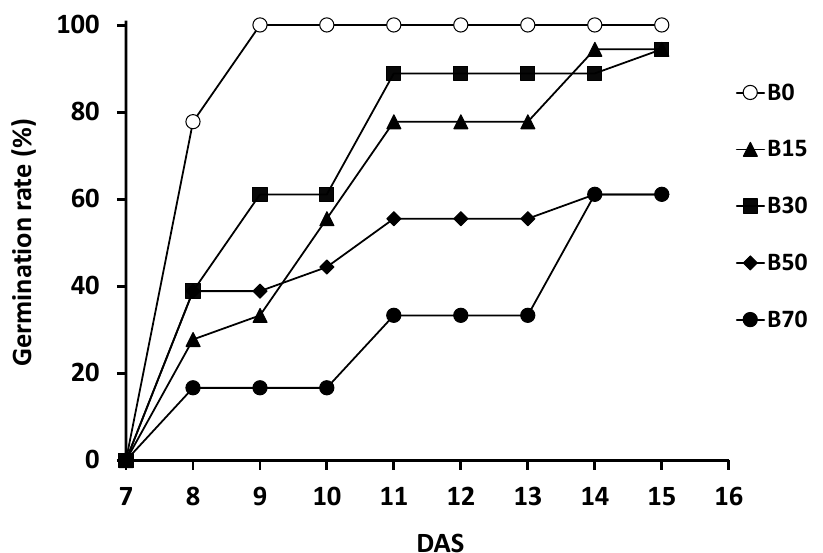
Figure 1. Germination rates of lettuce seeds sown on different biochar:peat substrate mixtures, with 0% (B0), 15% (B15), 30% (B30), 50% (B50) and 70% (B70) biochar contribution ( v / v ). Values are the accumulated percentage of seeds germinated at days counted. DAS, days after sowing.